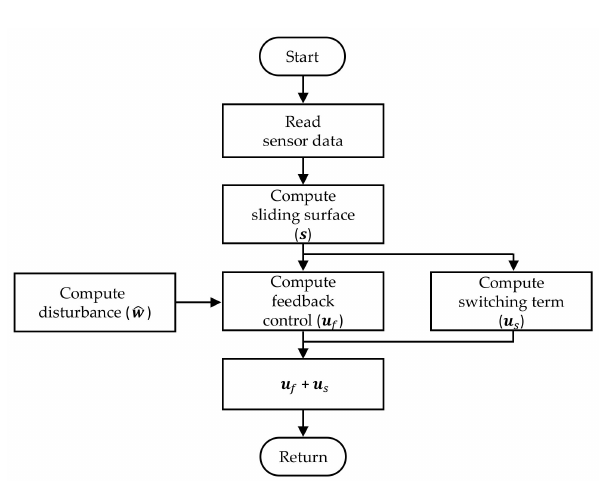
Figure 5. Flowchart of the sliding mode control